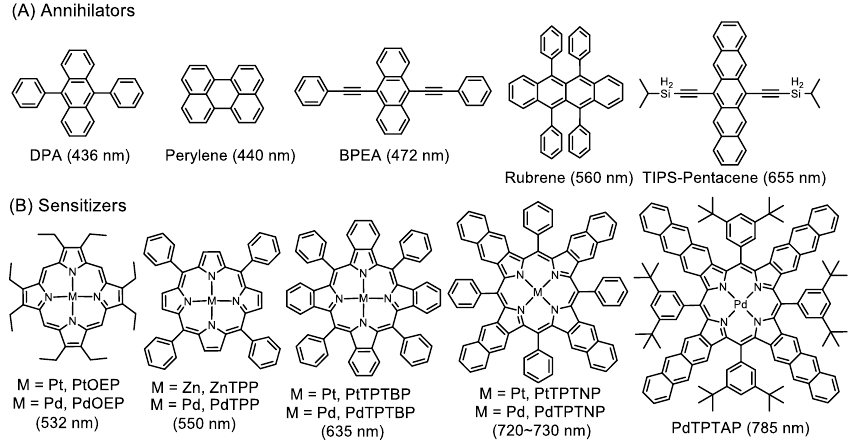
Figure 2. Chemical structures of commonly used annihilators and porphyrin-based sensitizers in TTA-UC and their corresponding emission and excitation wavelengths.